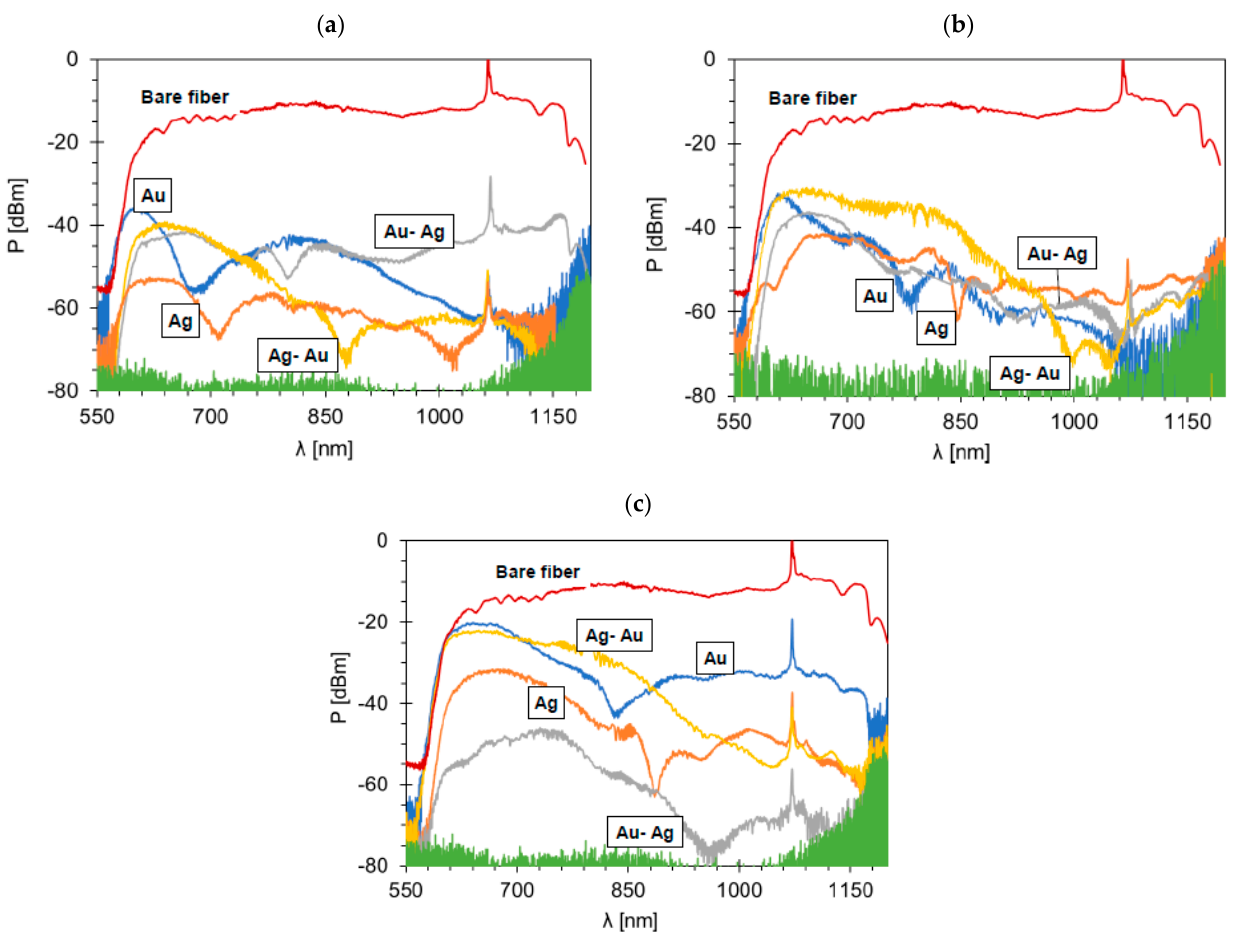
Figure 7. SPR dips were obtained for: ( a ) orthogonal; ( b ) parallel; ( c ) twisted cells with different metallic covers.